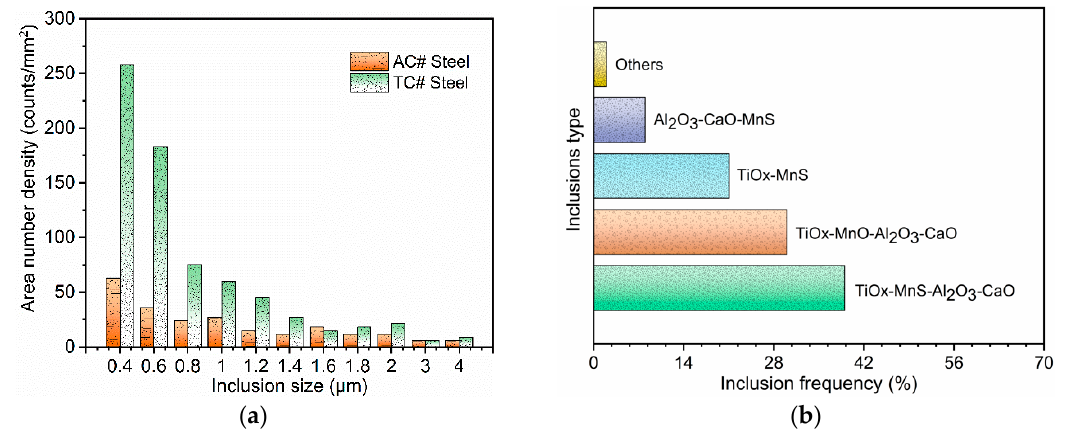
Figure 4. ( a ) Size distributions of inclusions in TC# and AC# steels; ( b ) frequency of each inclusion type in TC# steel. type in TC# steel.